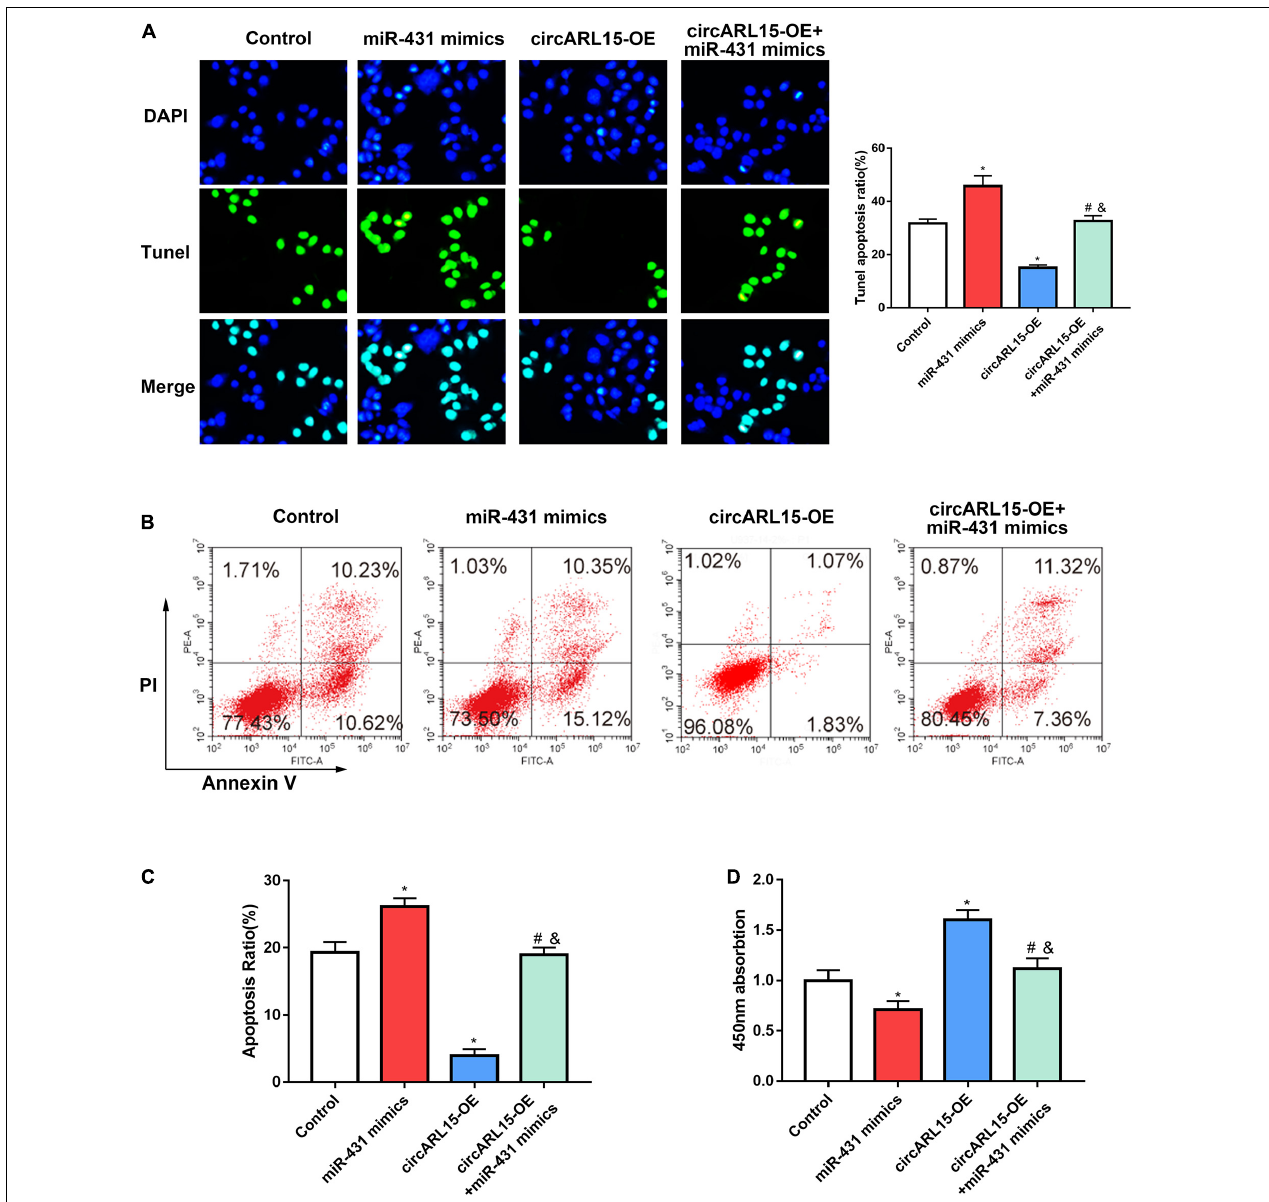
FIGURE 5 | Effects of circARL15 on cell apoptosis and cell proliferation. NP cells were treated with negative control, circARL15 overexpression (OE) plasmid, miR-431-5p mimics, and circARL15-OE + miR-431-5p mimics. (A) Tunel assay of NP cells treated with different groups. (B,C) Cell flow cytometry was carried out to explore the cell viability of NP cells. (D) CCK-8 assay was performed in NP cells 48h after transfections. * p < 0.05 compared with control; # p < 0.05 compared with miR-431-5p mimics. & p < 0.05 compared with